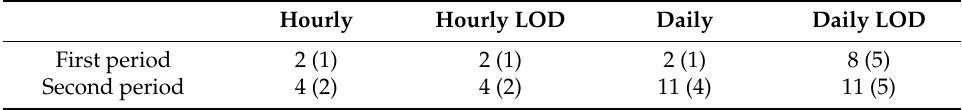
Table 2. Number of TEOM–Speck monitors data pairs (out of 24 and 26 during the first and second period) coming from identical populations, according to paired Wilcoxon Signed-Rank Test. Numbers in brackets show the number of (TEOM–Speck) pairs located in the city